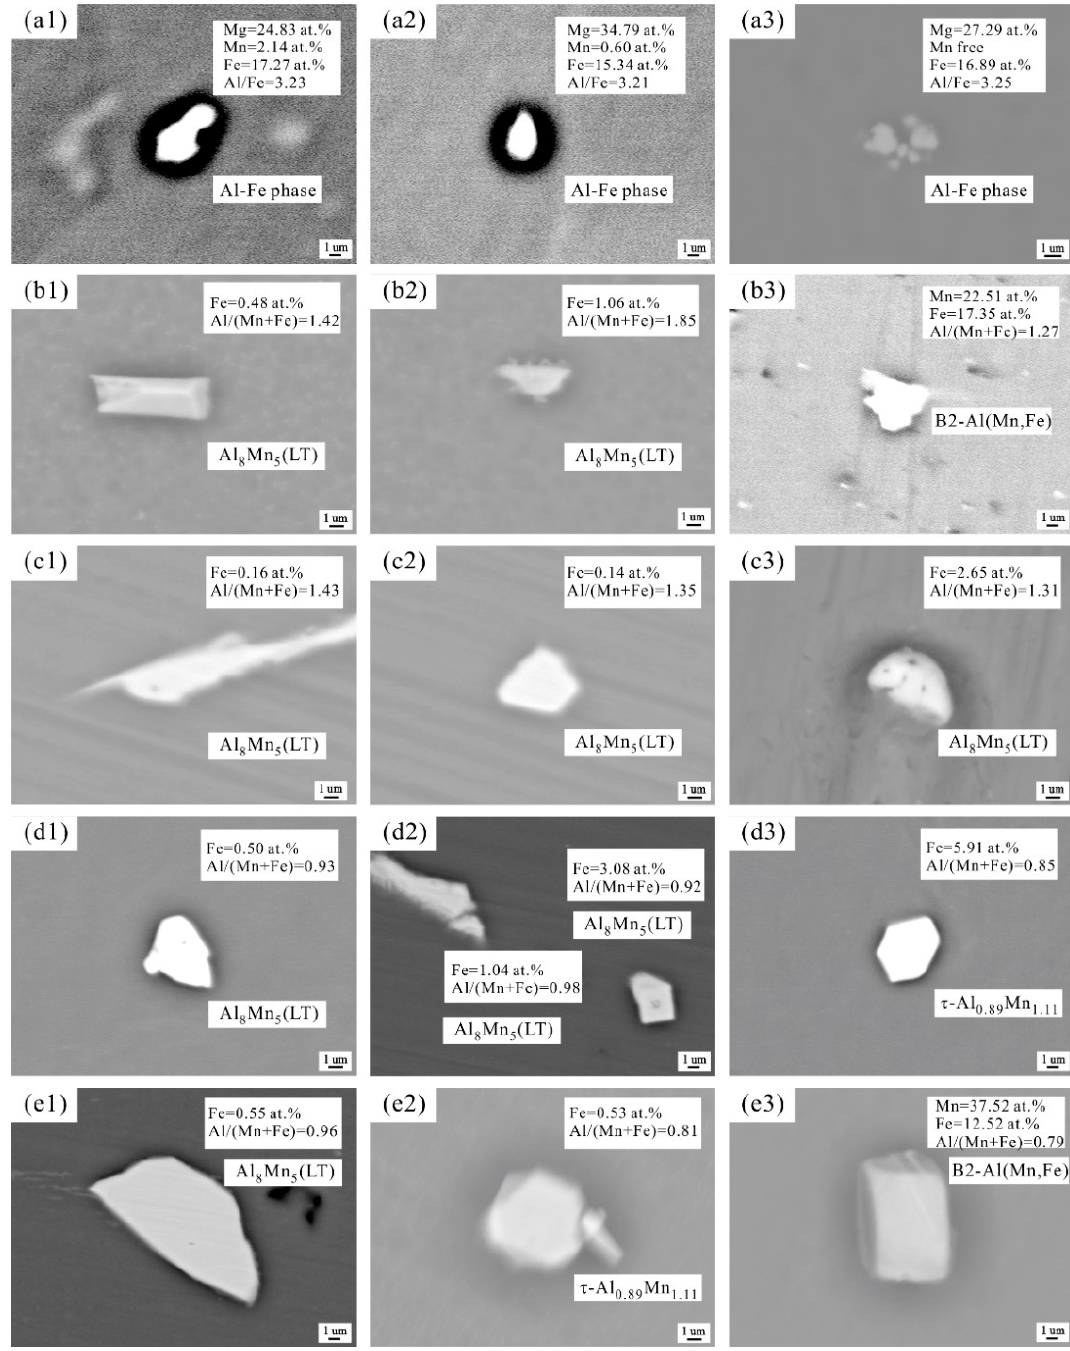
Figure 5. BSE images of typical particles in the mechanical polished Mg-3Al- x Mn alloys by EPMA: